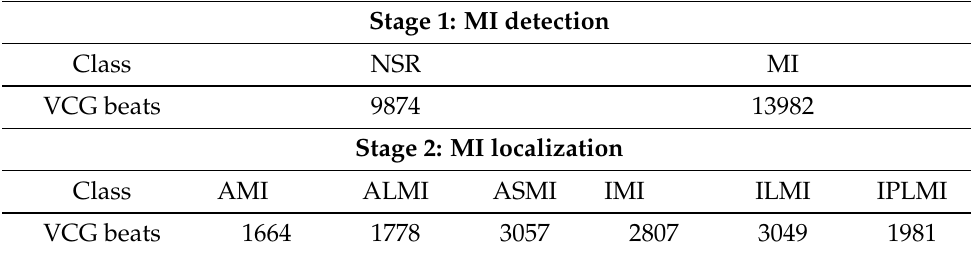
Table 1. Number of VCG beats used for MI detection and